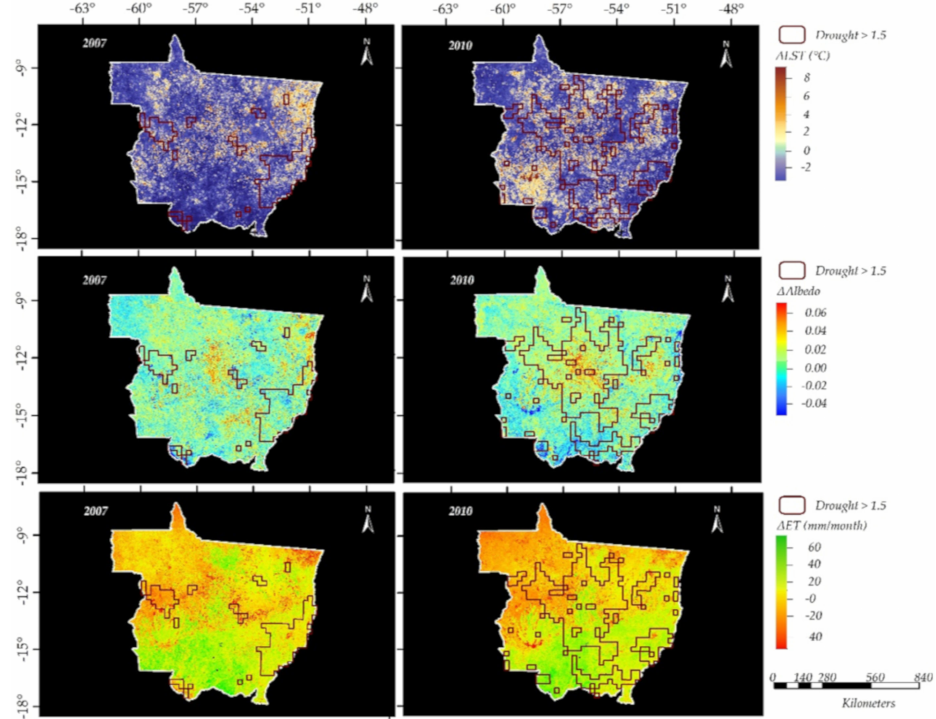
Figure A4. Land surface temperature (LST) (middle, obtained from the MOD11A2 product), albedo (bottom, obtained from the MOD11A2 product), and evapotranspiration (ET) (top, obtained from the MOD16 product) in the areas where the drought exceeded 1.50 standard deviations of the mean (higher or lower). The areas outside the red polygons are those in which the drought was ≤ 1.49 SD of the